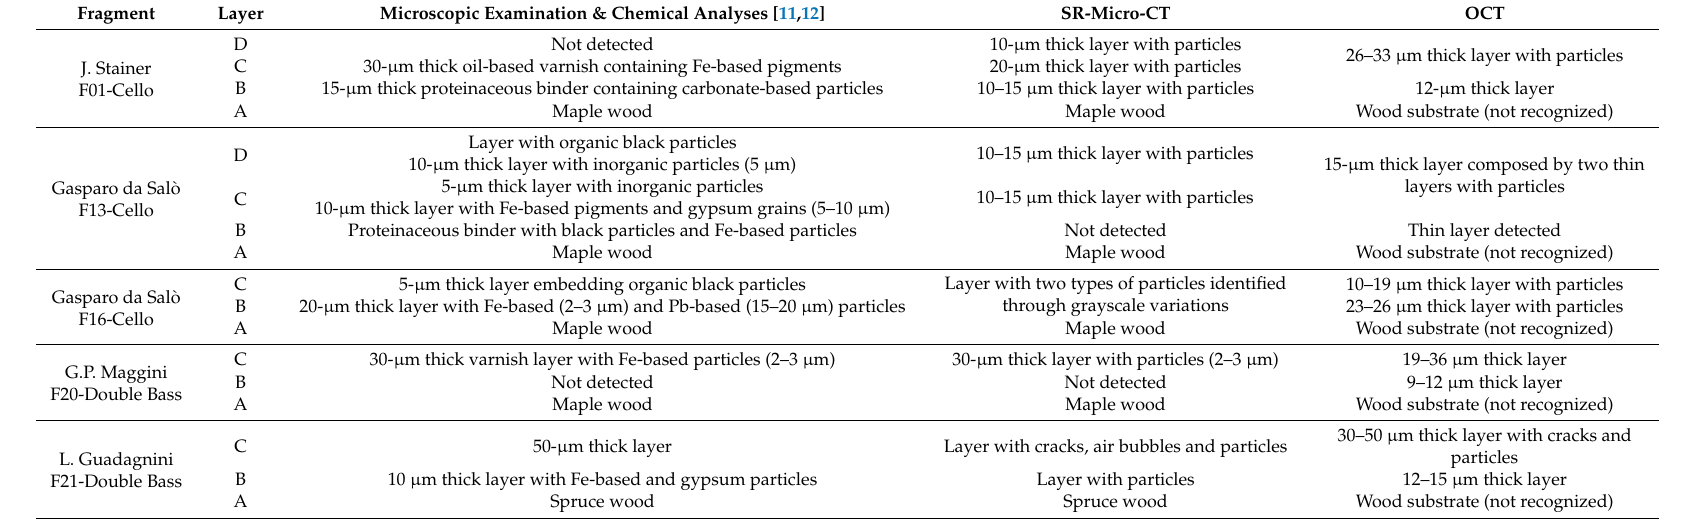
Table 1. List of the selected historical musical instruments fragments with a schematic comparison of the finishing layers according to previous data [11,12] and to the present results from SR-micro-CT and OCT scans. Capital letters indicate each layer are the same as those in Figures 3–7. Horizontal lines guide the eye and separate the detected